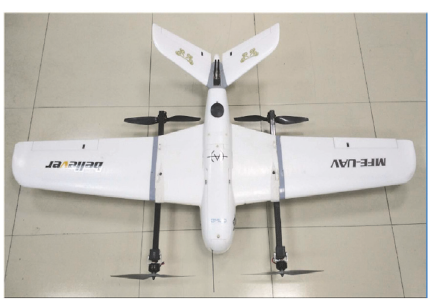
Figure 17: Overview of the developed DTR aircraft.